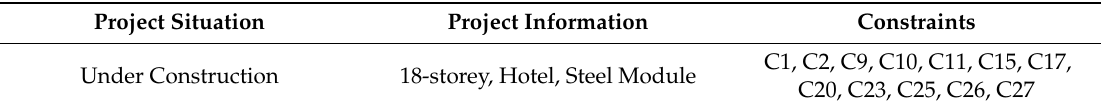
Table 7. Survey of high-rise modular building